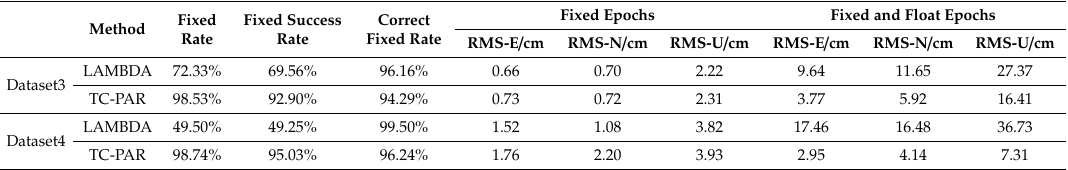
Table 5. Kinematic experiment results of LAMBDA and